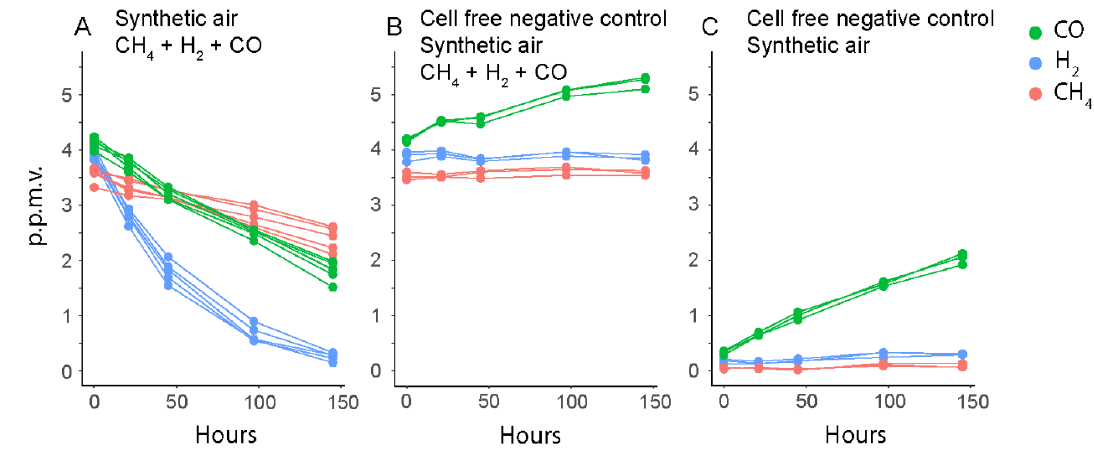
Figure 5. Oxidation of CH 4 , CO, and H 2 by M. gorgona MG08. ( A ) filters with M. gorgona MG08 floating on nitrate mineral salts medium. ( B , C ) sterile filters floating on nitrate mineral salts medium. All gases used were of the highest commercially available quality, 6.0 (99.9999% purity). The multiple data points in each color represent different biological replicates from the same condition.